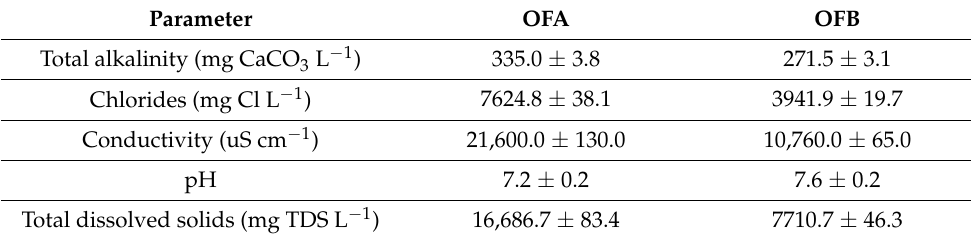
Table 1. Physicochemical properties of the produced waters of OFA and